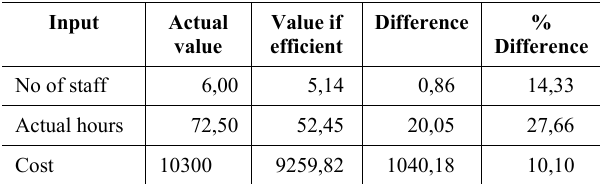
Table 5: Results of audit project No